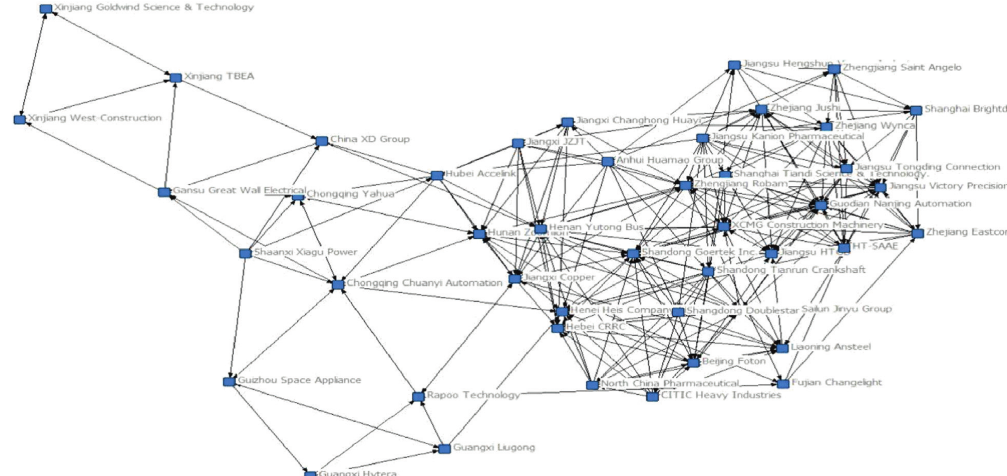
Figure 1: Spatial correlation network of the innovation efficiency of the IM enterprises in 2015.